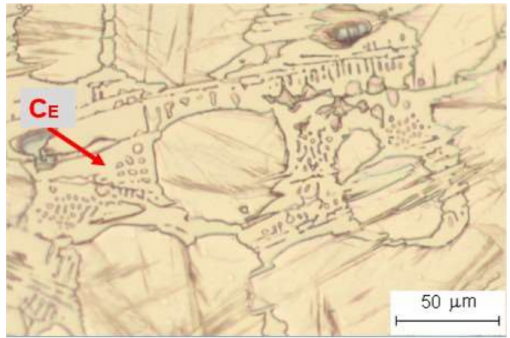
Figure 1. Marshall reagent for 5 s at room temperature (200 × ).